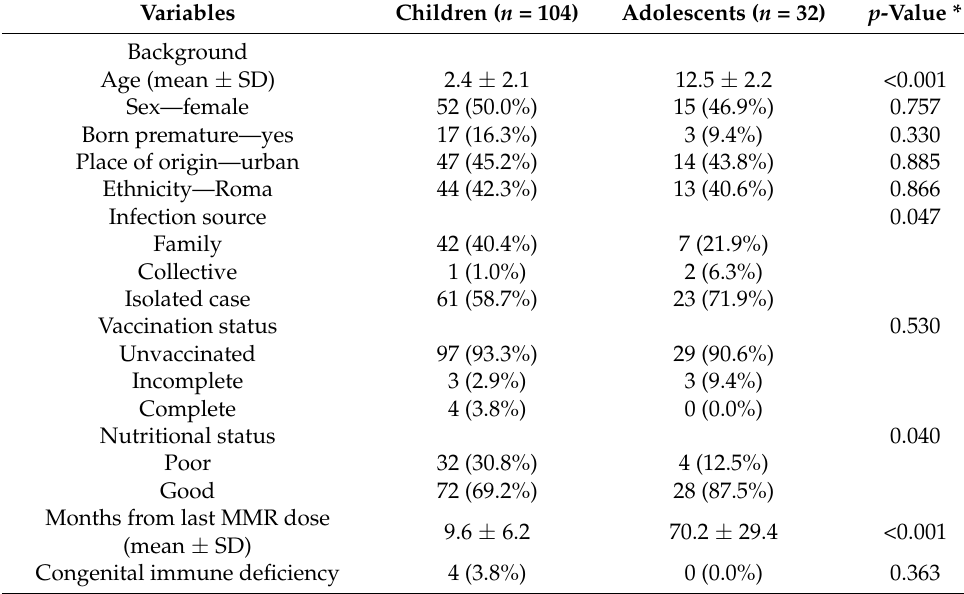
Table 1. Comparison of background characteristics of patients admitted with measles by the duration of hospital